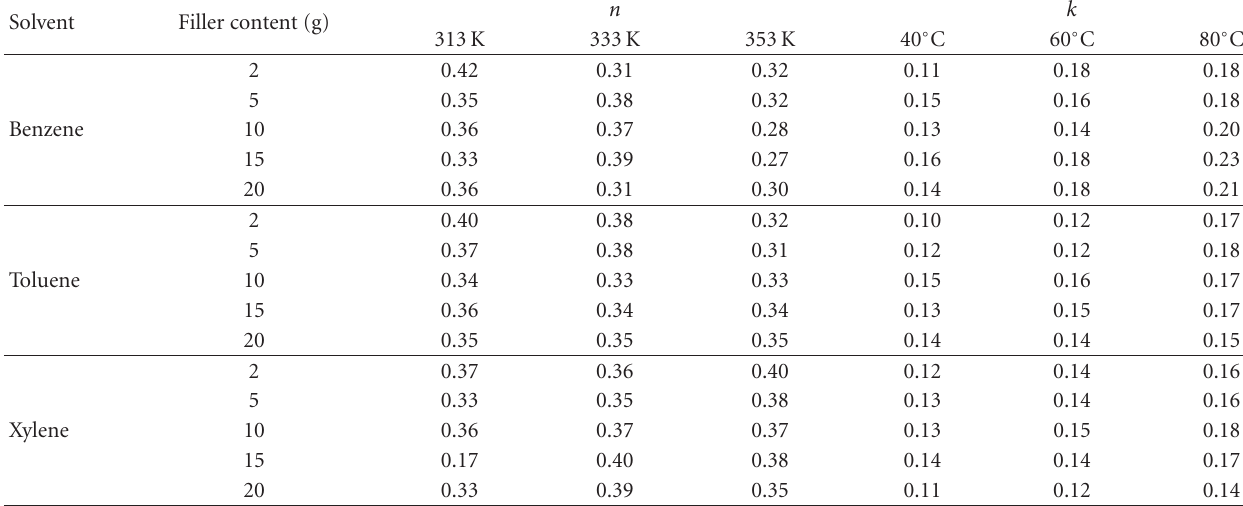
Table 9: Values of n and k for snail shell powder filled natural rubber at di ff erent temperatures (filler particle size, 0.075 μ m). Solvent Filler content (g)